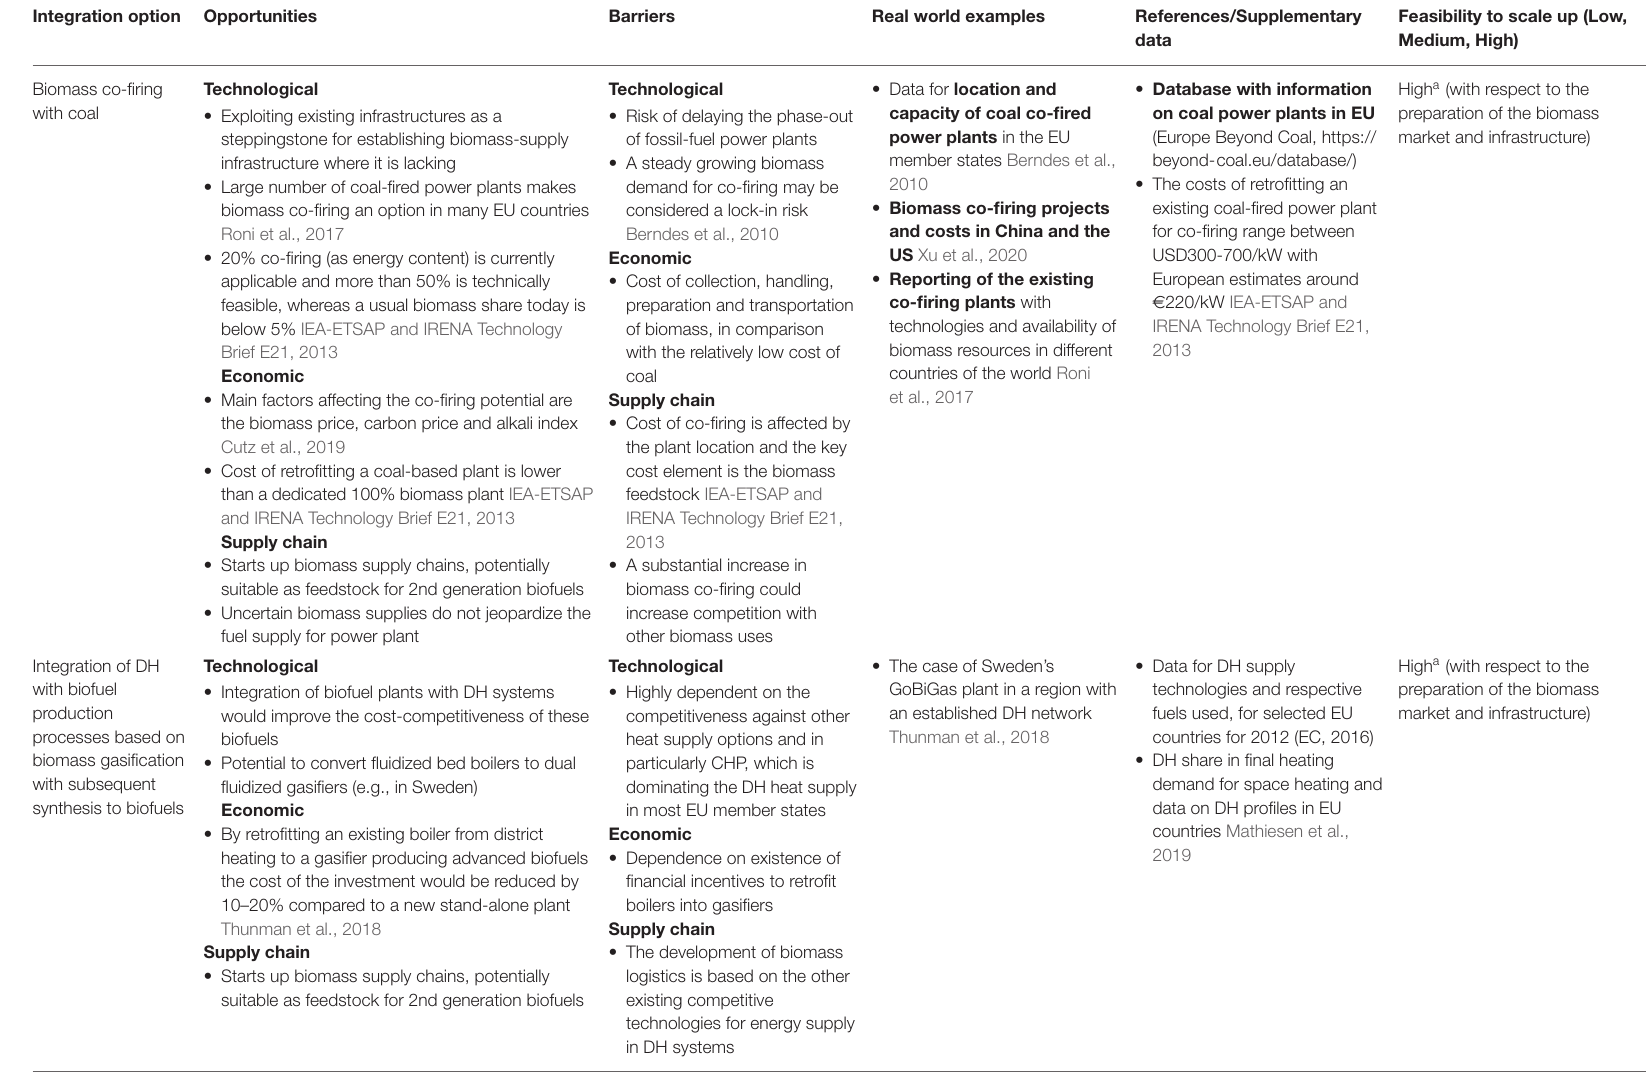
TABLE 2 | Indirect integrated options of biomass use in fossil